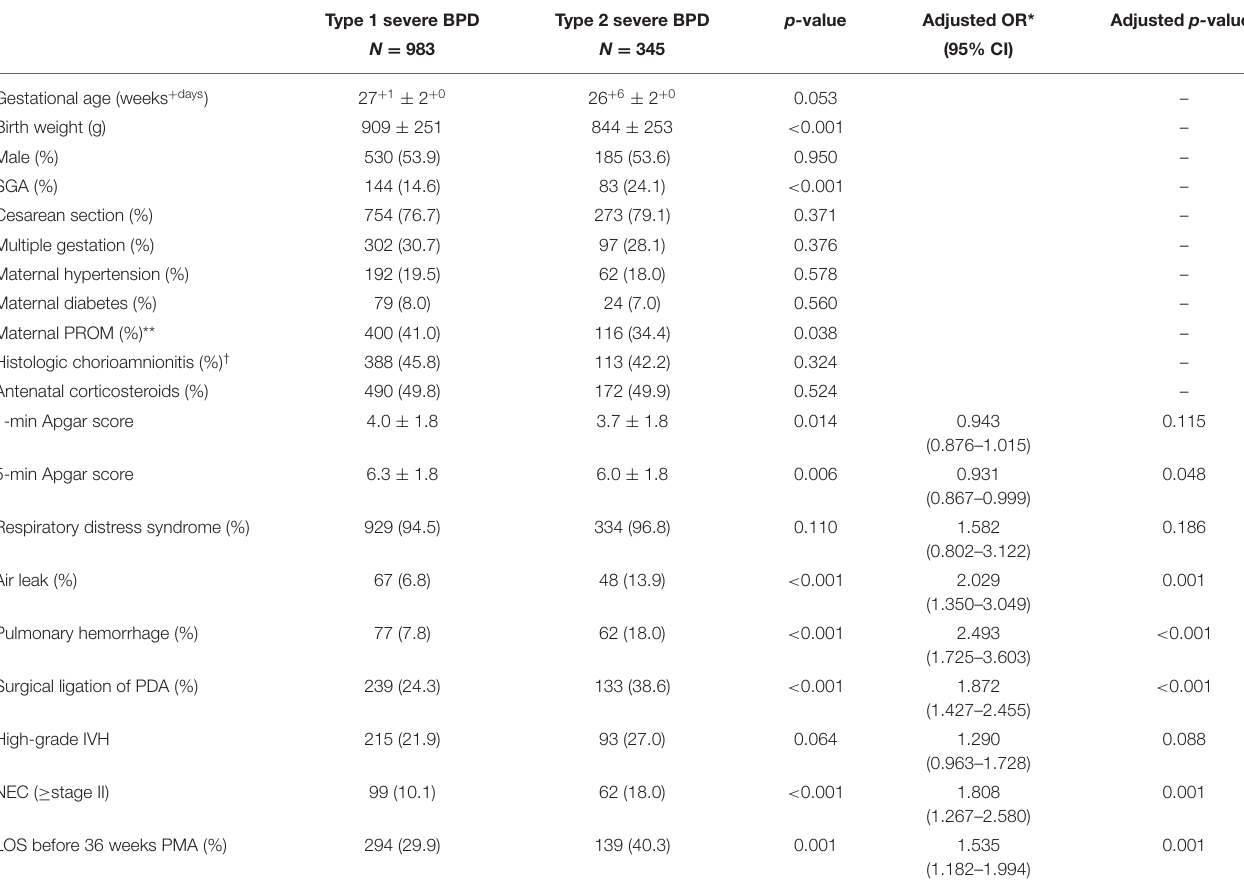
TABLE 1 | Comparisons of baseline characteristics between the type 1 severe BPD and type 2 severe BPD